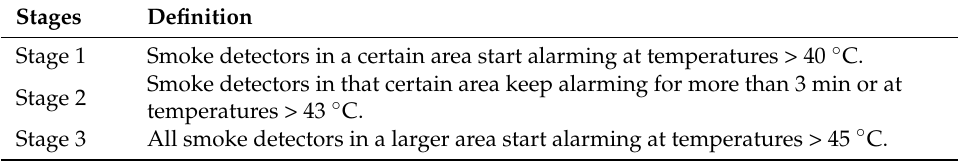
Table 1. Fire stages in the multi-stage fire alarm